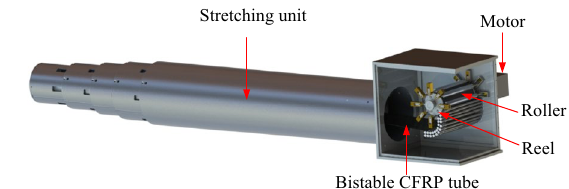
Figure 1 Main structure of each part of